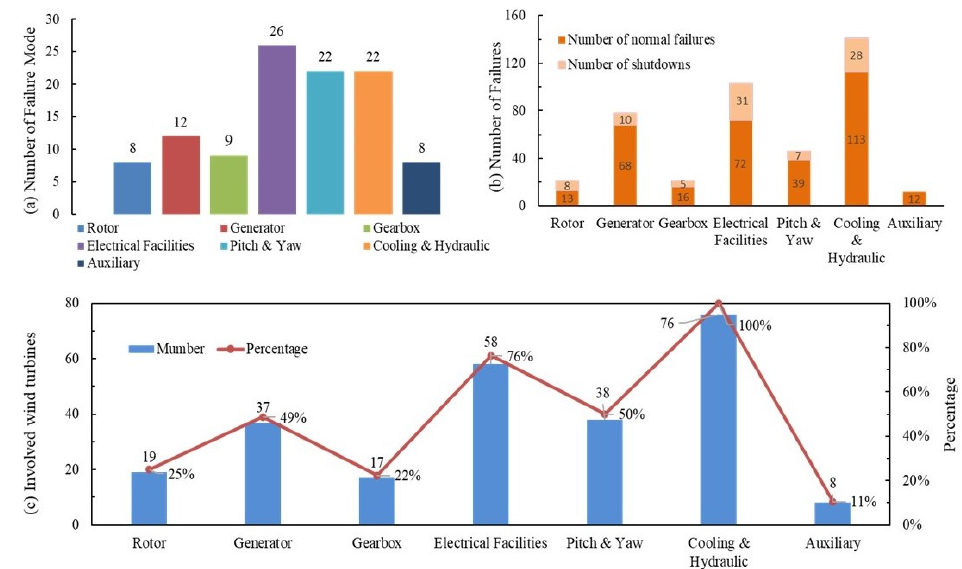
Figure 3. Failures of components. ( a ) Number of failure mode instances; ( b ) number of failures; and ( c ) involved wind turbines.